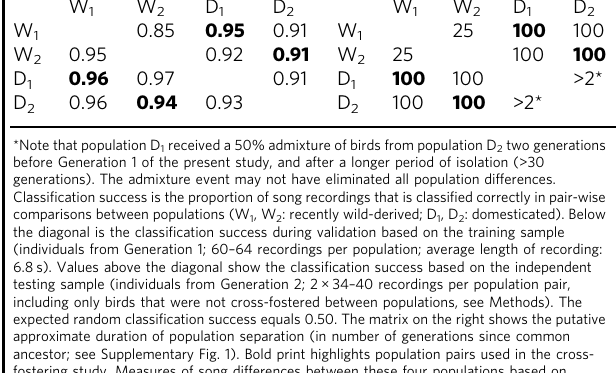
(individuals from Generation 1; 60 – 64 recordings per population; average length of recording: 6.8s). Values above the diagonal show the classi fi cation success based on the